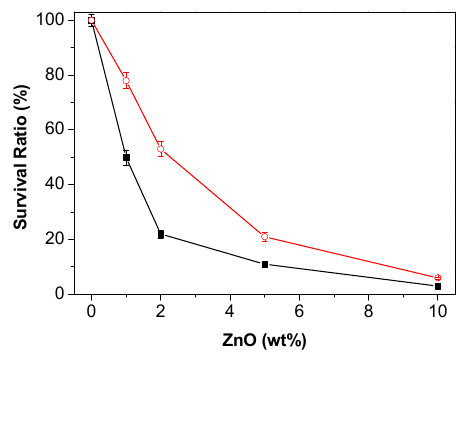
Figure 11. Effect of PHB/ZnO nanocomposites on the survival ratio of E. coli (solid squares) and S. aureus (open